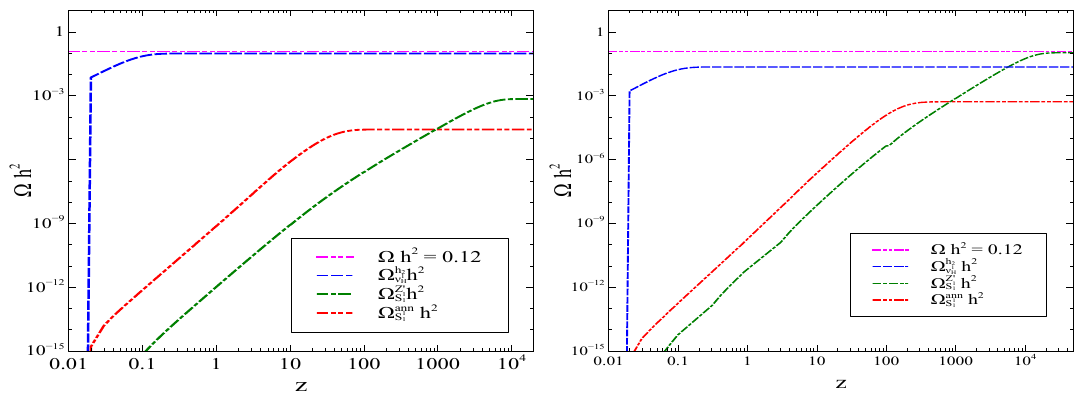
Figure 11 . Variation of relative relic density contributions of (cid:23) 1 two di(cid:11)erent sets of model parameters as follows. Left (right) panel: M Z 0 = 10 GeV (2 : 5 GeV), M = 8 GeV (2 GeV), M = 10 keV (100 keV), (cid:11) = 0 : 01 rad, g 0 ’ 2 : 4 (cid:2) 10 (cid:0) 11 , M h (cid:23) 1 H S 1 1 z 0 = 0 :